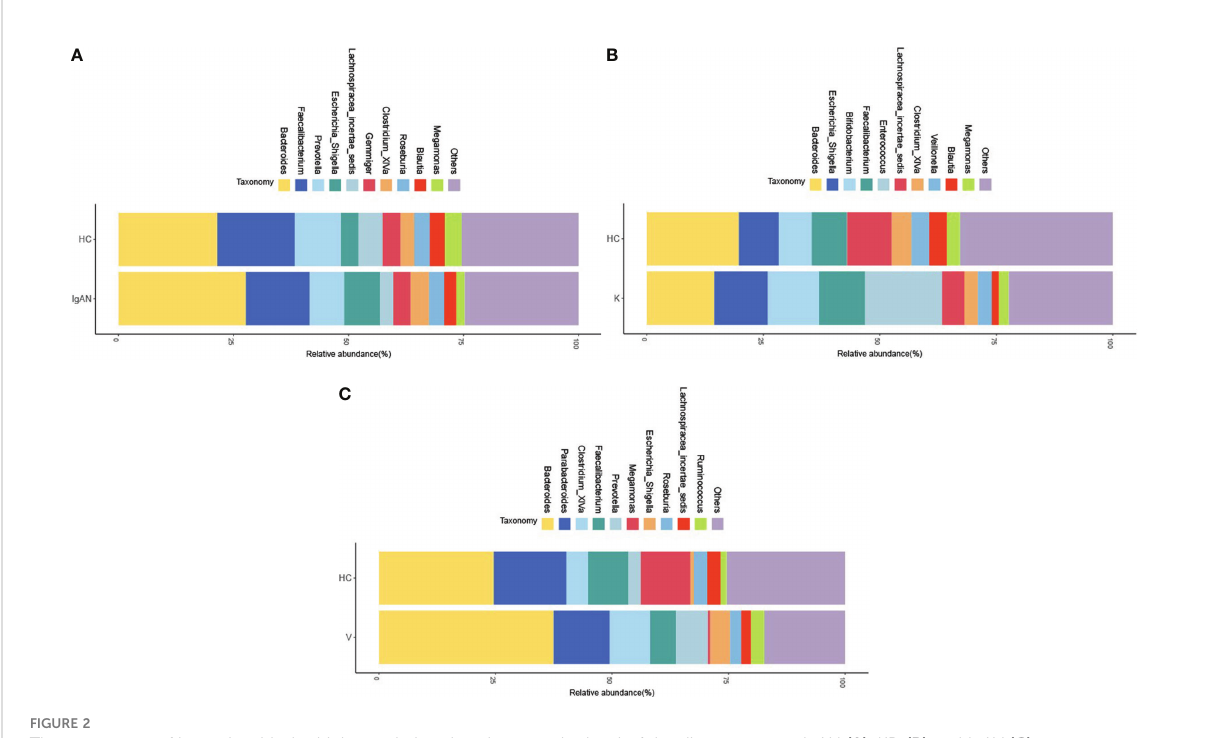
FIGURE 2 The ten groups of bacteria with the highest relative abundance at the level of the disease genera IgAN (A) , KD (B) and IgAV (C) .